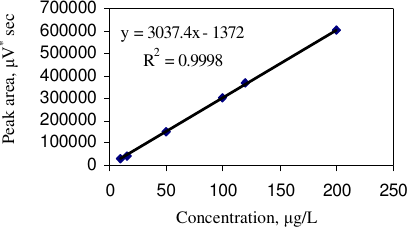
Figure 6. Bromate ion calibration curve